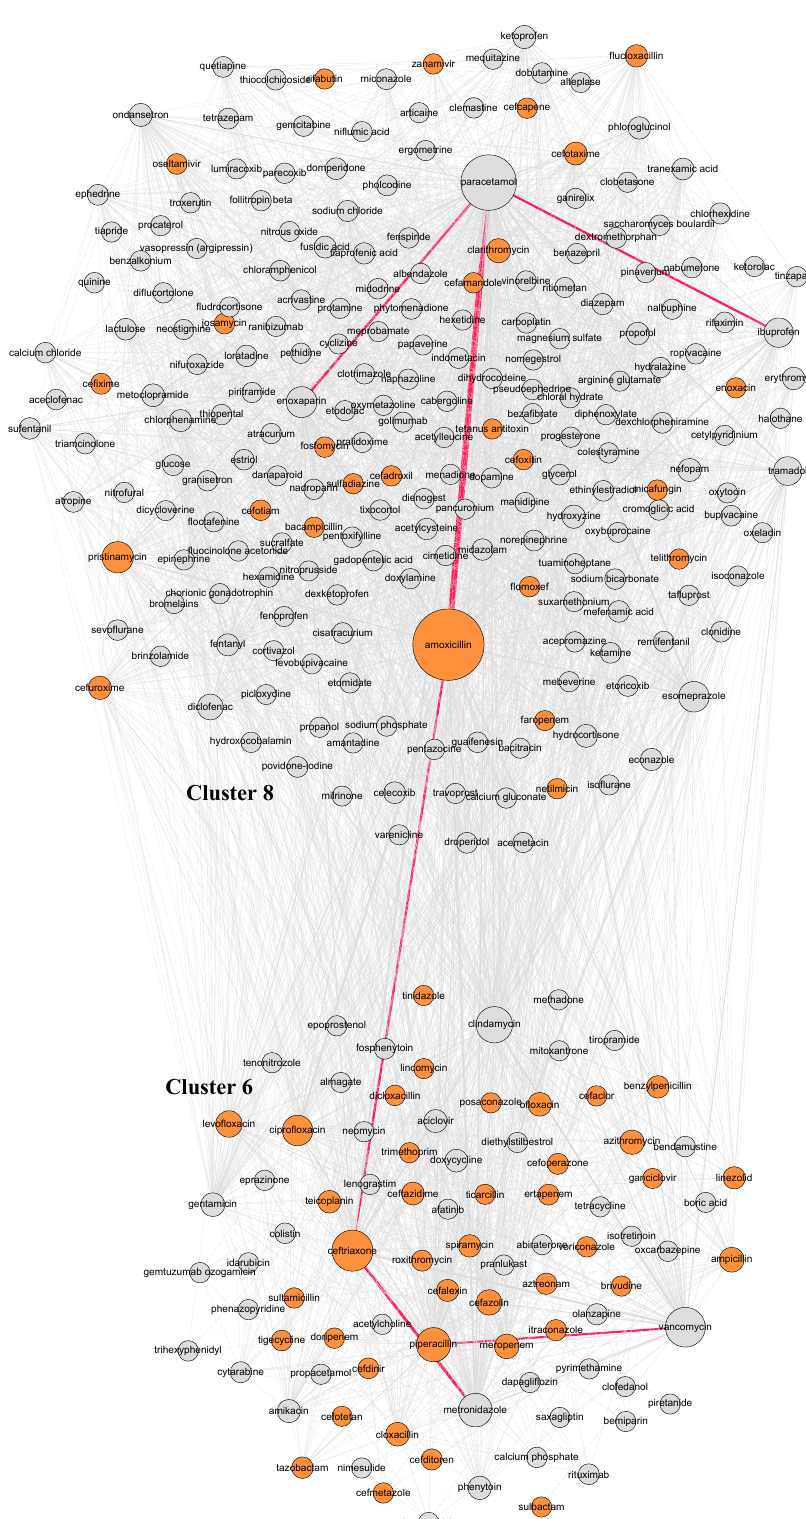
Figure 3 . Clusters 6 and 8 (antimicrobial clusters) with antibiotic drugs highlighted in orange, and most relevant edges highlighted in red. Notes: Nodes represent medications, the sizes of the nodes are proportional to the prevalence of the drug, the links indicate that the two connected drugs were taken concomitantly, the width of the link is proportional to the number of times the pair of drugs was reported.